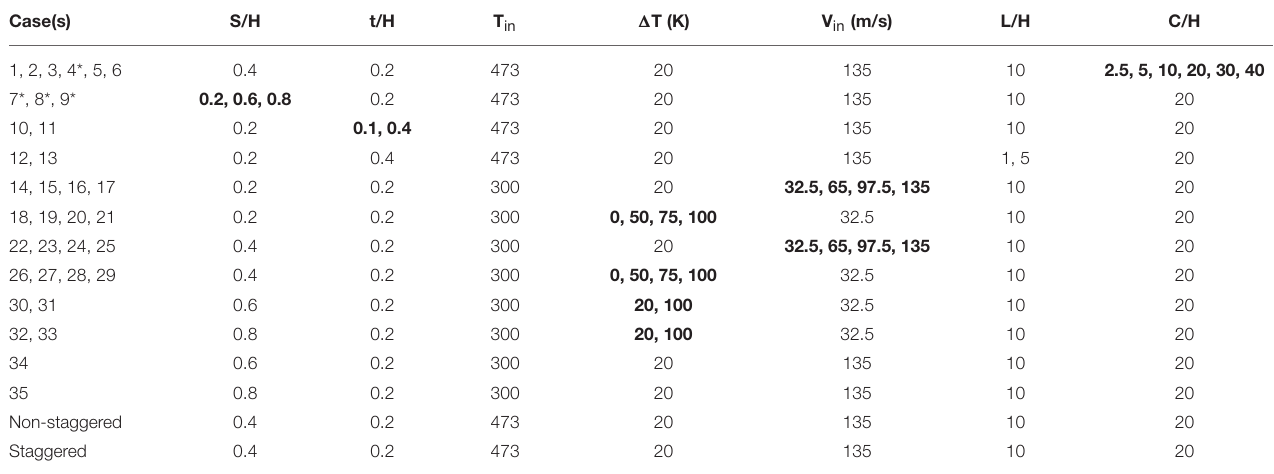
TABLE 1 | Summary of cases studied +